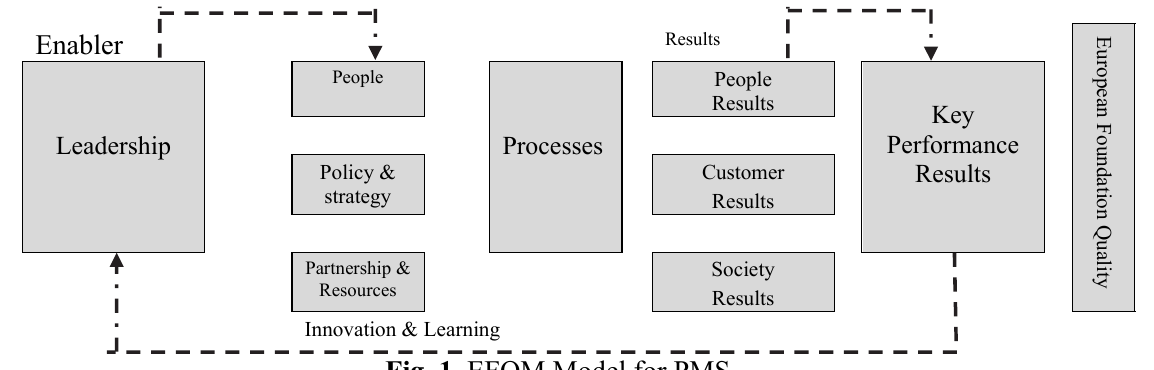
Fig. 1. EFQM Model for